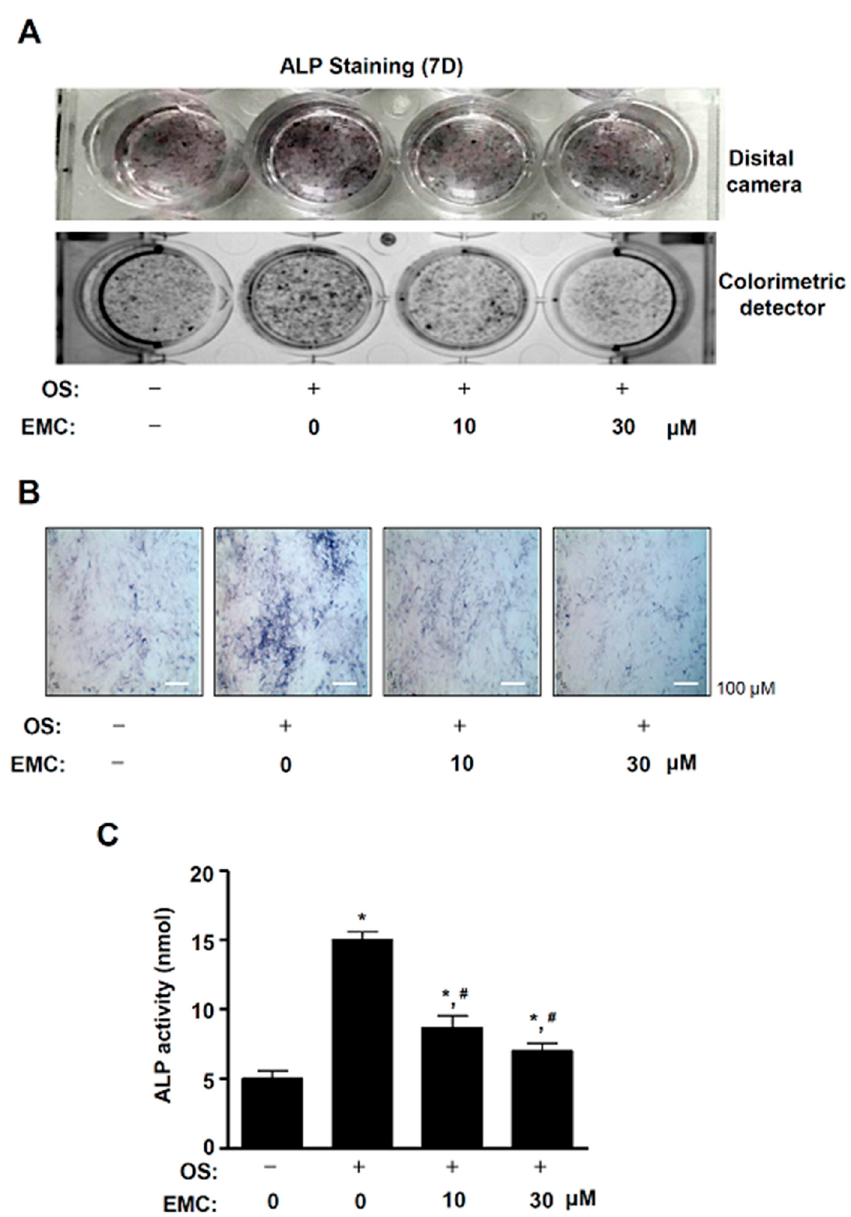
Figure 7. EMC suppresses the osteoblast di ff erentiation of pre-osteoblasts. ( A , B ) Pre-osteoblasts were cultured in OS containing 50 µ g / mL L-AA and 10 mM β -GP in the absence and presence of EMC for 7 days. Then ALP staining was observed by a disital camera ( upper ) and colorimetric detector ( bottom ) ( A ). The individual ALP-stained cells were detected using a light microscope ( B ). ( C ) Under the same condition, ALP activity was measured at 405 nm by the Multiskan GO Microplate Spectrophotometer. Scale bar: 100 µ m. The results are representative of three independent experiments. The data are expressed as the mean ± S.E.M. of experiments. * ( p < 0.05) indicates statistically significant di ff erences compared to the control. # ( p < 0.05) indicates statistically significant di ff erences compared to the OS.